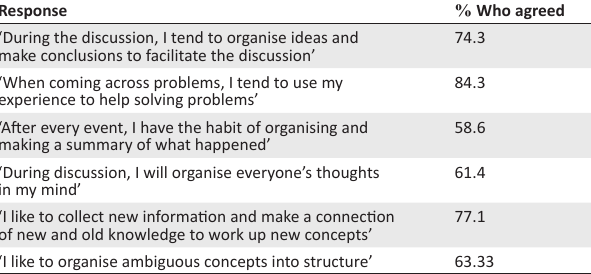
TABLE 2: Respondents’ use of